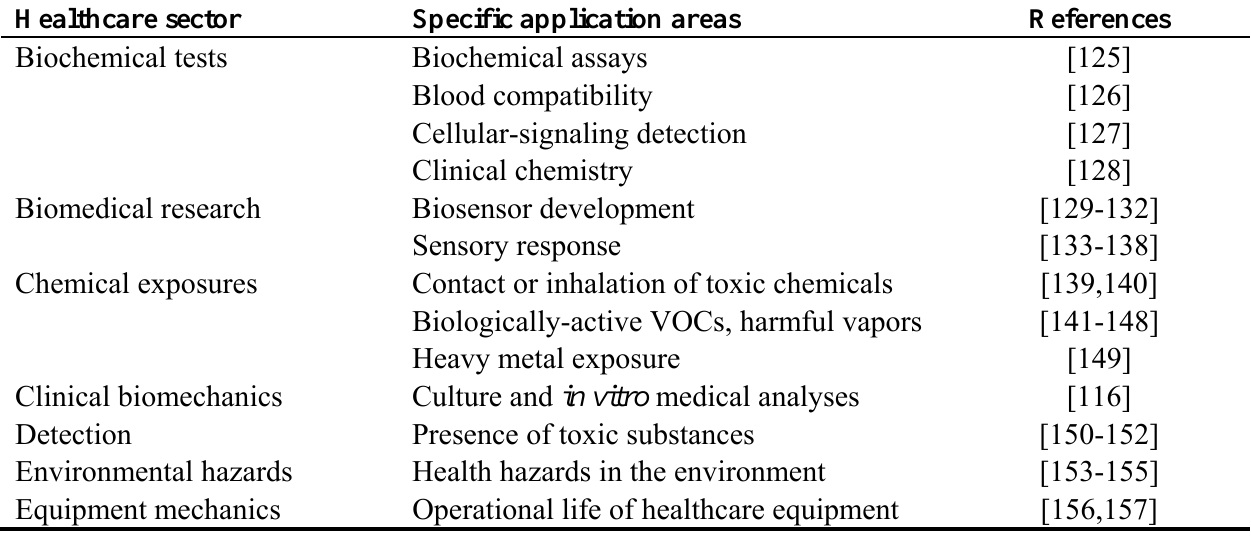
Table 2. Some major categories of potential electronic-nose applications within various sectors of the healthcare and biomedical